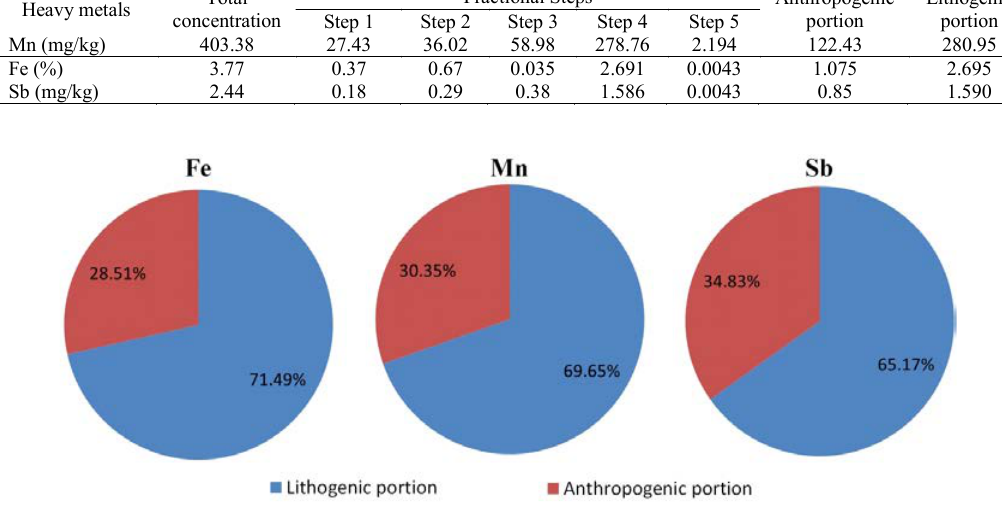
Fig. 3: Anthropogenic and lithogenic portion of Fe, Mn and Sb in the agricultural soil of Hamedan area